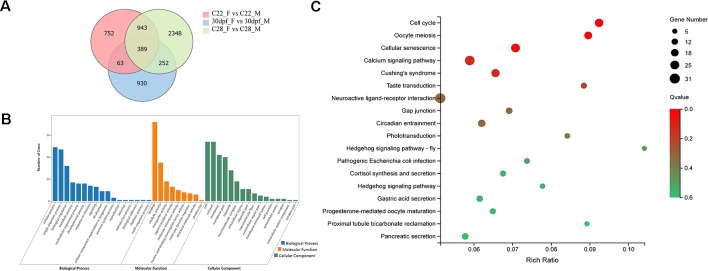
Analysis of DEGs between females and males. (A) Number of DEGs between females and males shown by Venn diagram. (B) GO classifications of 943 DEGs belong to C22_F vs C22_M and C28_F vs C28_M excluding 30dpf_F vs 30dpf_M. (C) Enriched KEGG pathways of the 943 DEGs (p < 0.05).